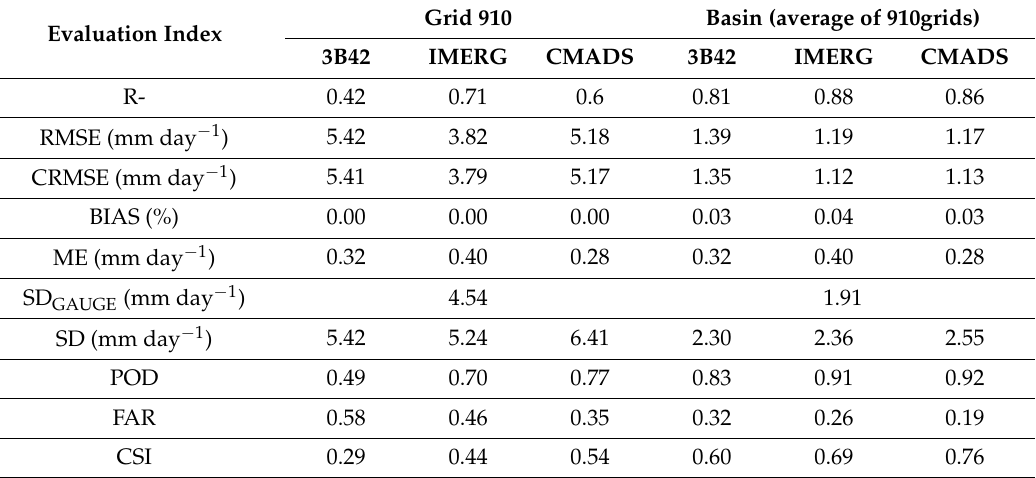
Table 2. Error markers (the whole study